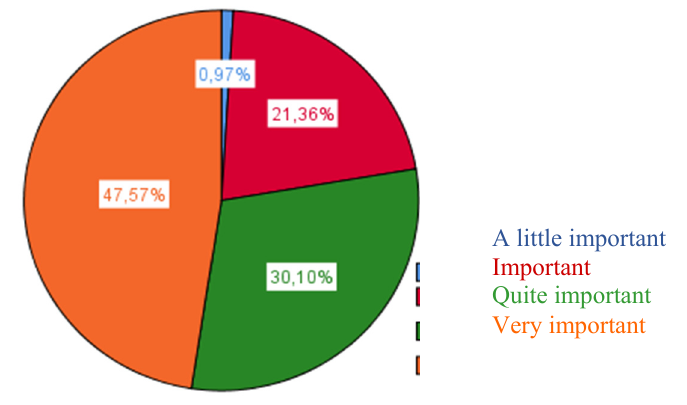
Figure 1. Sociocultural characteristics and needs of the immediate environment.